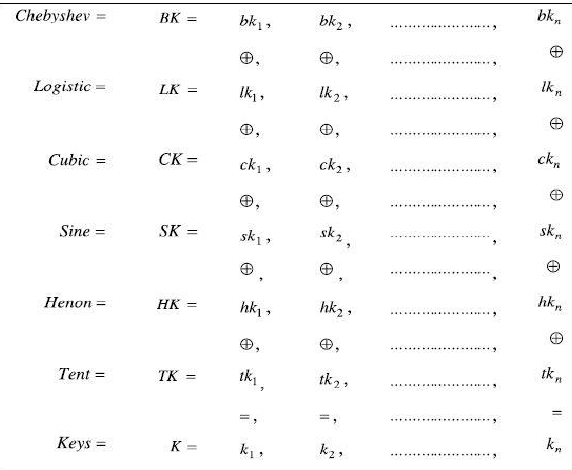
Figure 5. Combination between mapping Chaos (Usama 2010) Then, the matrix derived from the encryption with the Hash function block is again combined with the help of the Hash matrix generated initially and the XOR key, and at the final stage of the output matrix, the incoming input matrix is